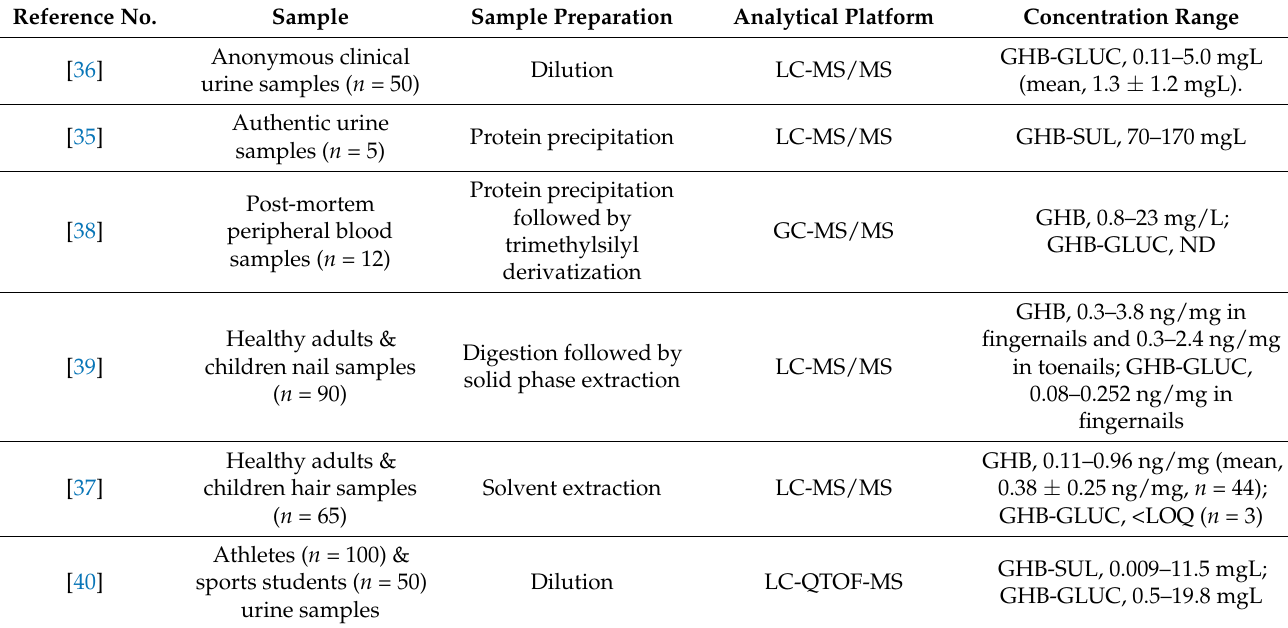
Table 2. Summary of analysis of GHB conjugates in human biological samples from non-GHB users. Reference